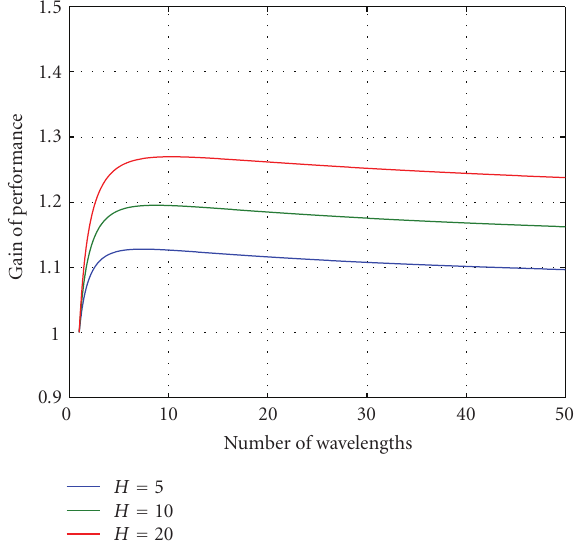
Figure 9: The gain of wavelength conversion G W = f ( W ), P b = 10 − 3 , F = 10, k = 3, and